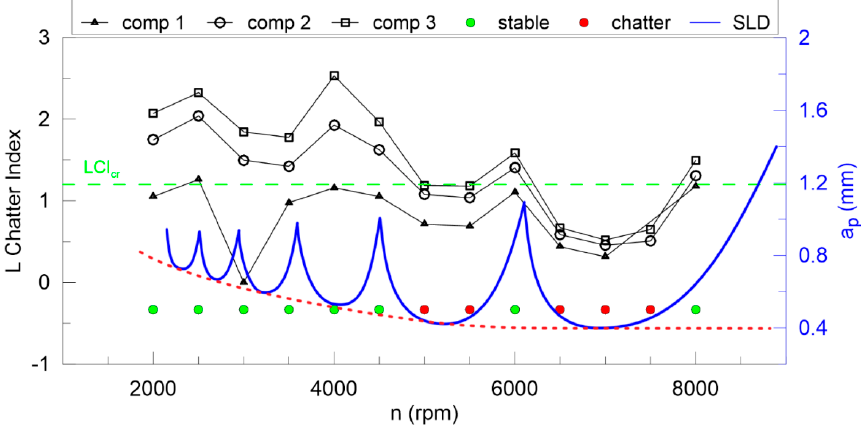
Figure 16. The L chatter index (left axis) and the hypothetical stability lobe diagram (right axis) versus cutting velocity.